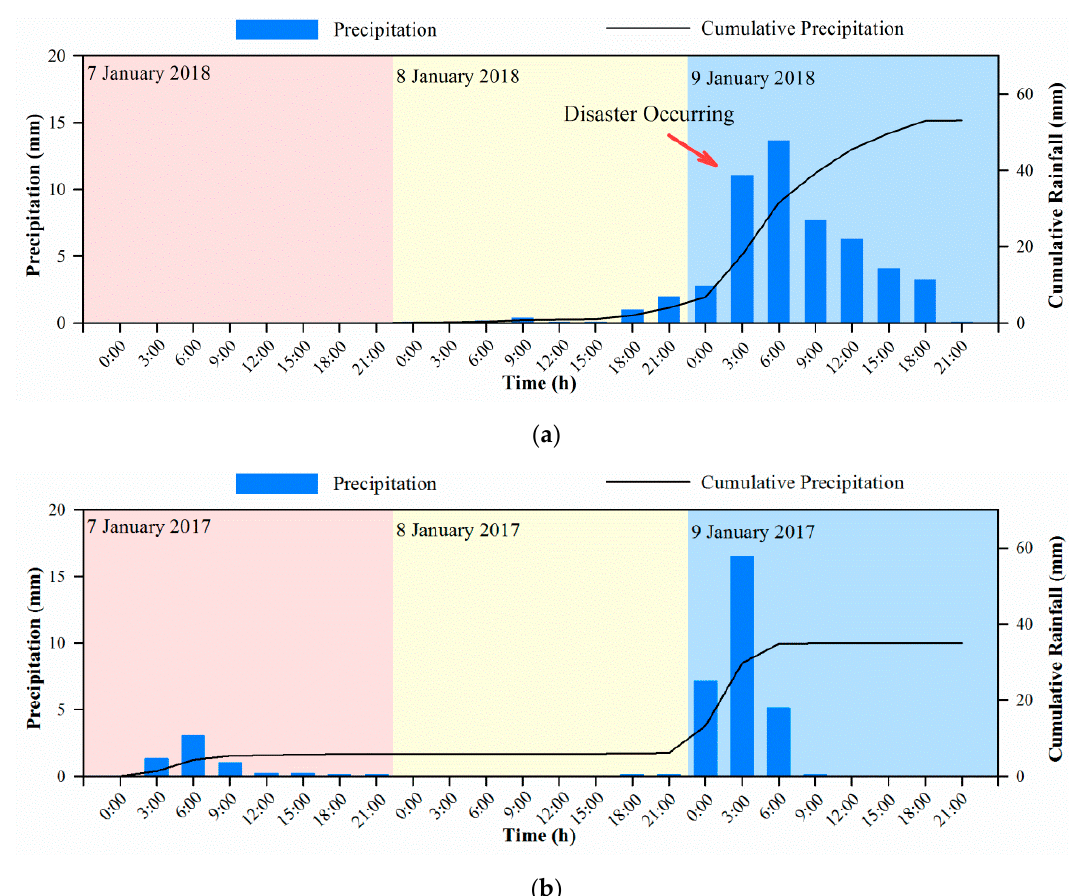
Figure 8. Rainfall in Montecito during the period from ( a ) 7 January to 8 January 2018 with a cumulative precipitation of less 13.7 mm; ( b ) 7 January to 8 January 2017 with a cumulative precipitation of 16.5 mm [38].